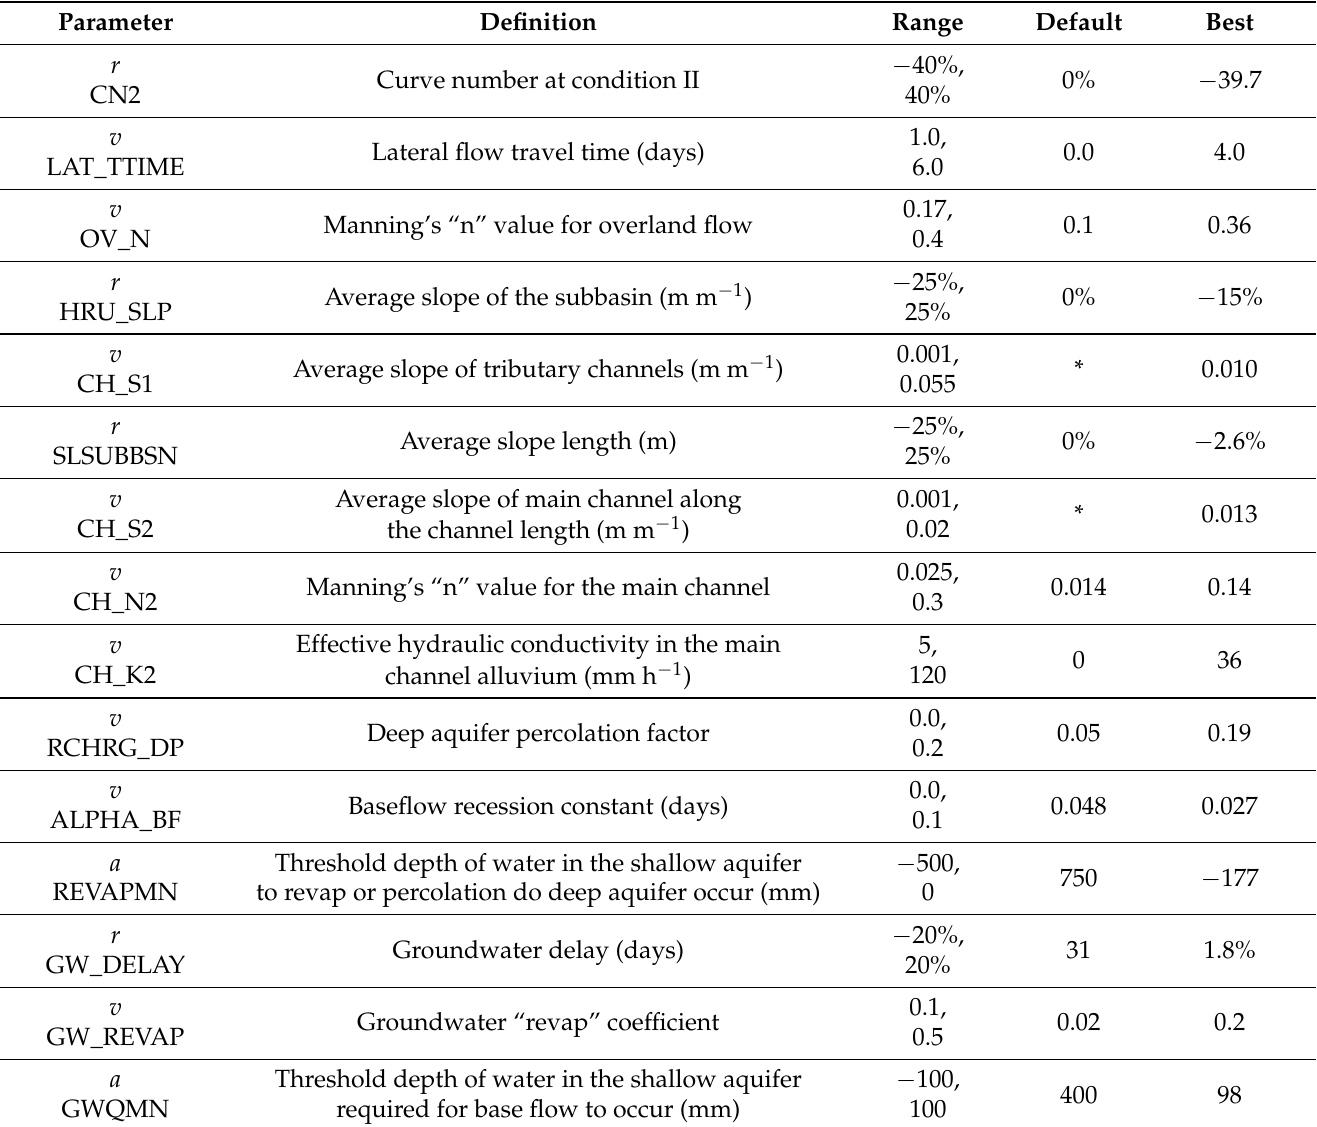
* Multiple values are found for the respective